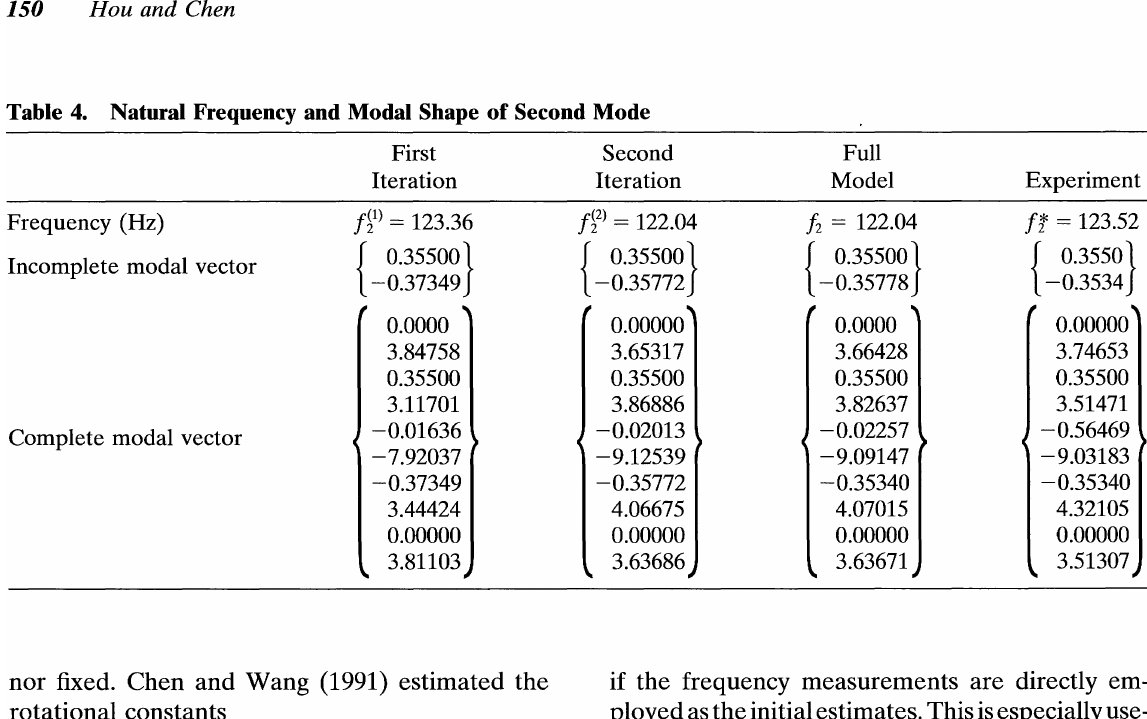
Table 4. Natural Frequeucy and Modal Shape of Second Mode